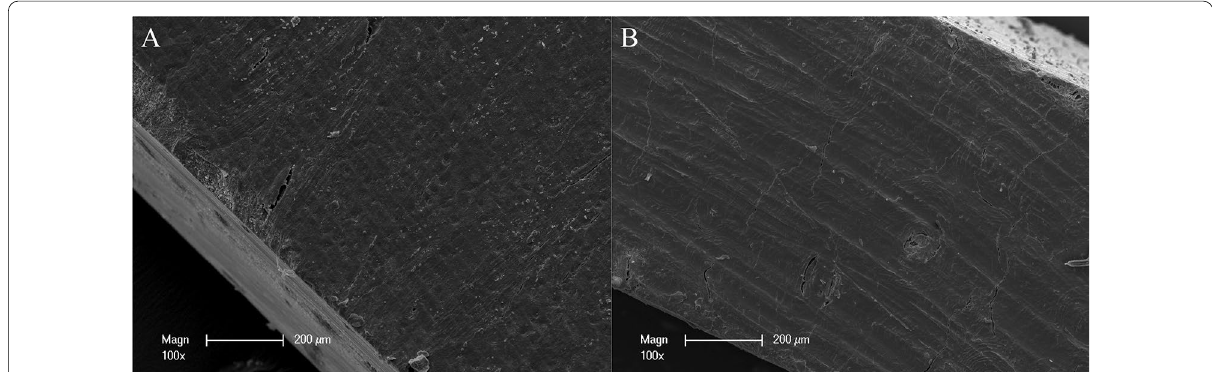
Fig. 1 Overview about the microscopic structure and architecture of A the surface and B the side of an allogeneic cortical bone plate by scanning electron microscopy (SEM) at 100-fold magnification. SEM demonstrating the compact structure of allogeneic cortical bone plate that is suitable for a sufficient barrier and stabilization function